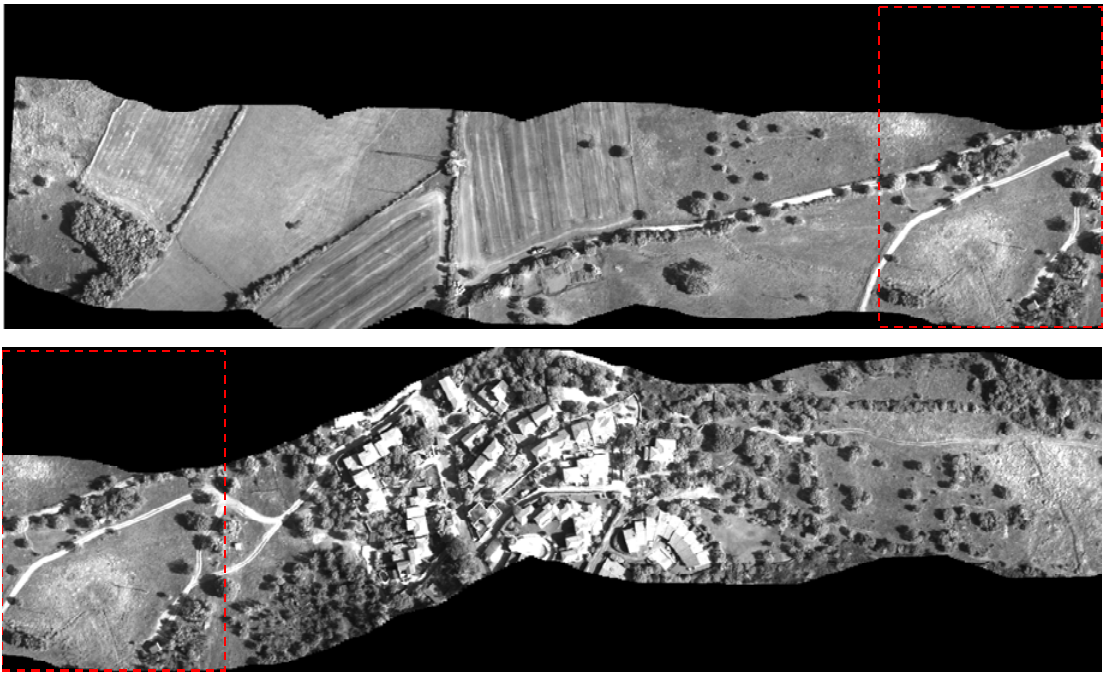
Figure 12. Result of the mosaicing procedure applied to 500 images acquired with the camera Dalsa 4M60 equipped with a standard lens. For a better interpretation of the image, the entire mosaic has been split into two parts; the common portion is highlighted within a dashed rectangular